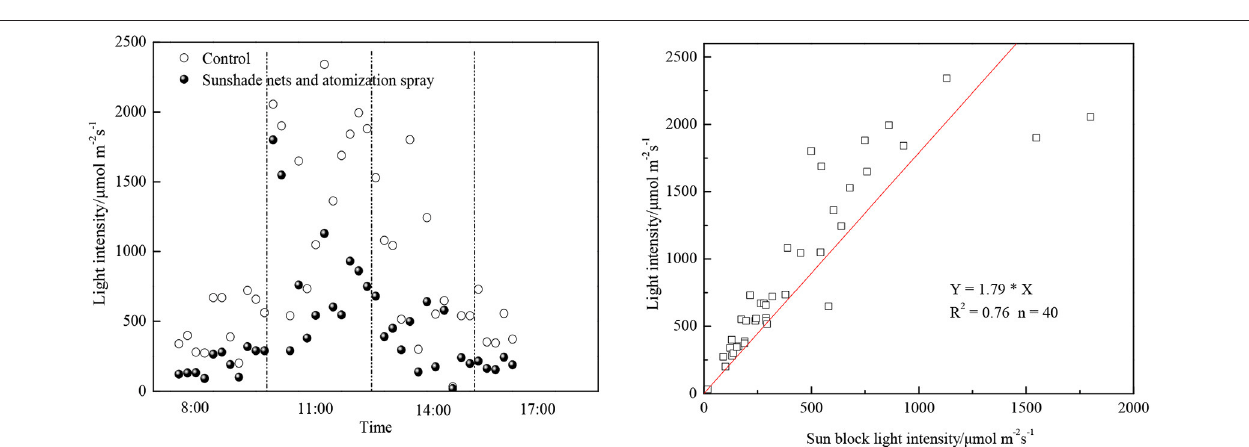
FIGURE 3 | Sun block effects of combining sunshade nets and atomization spray.